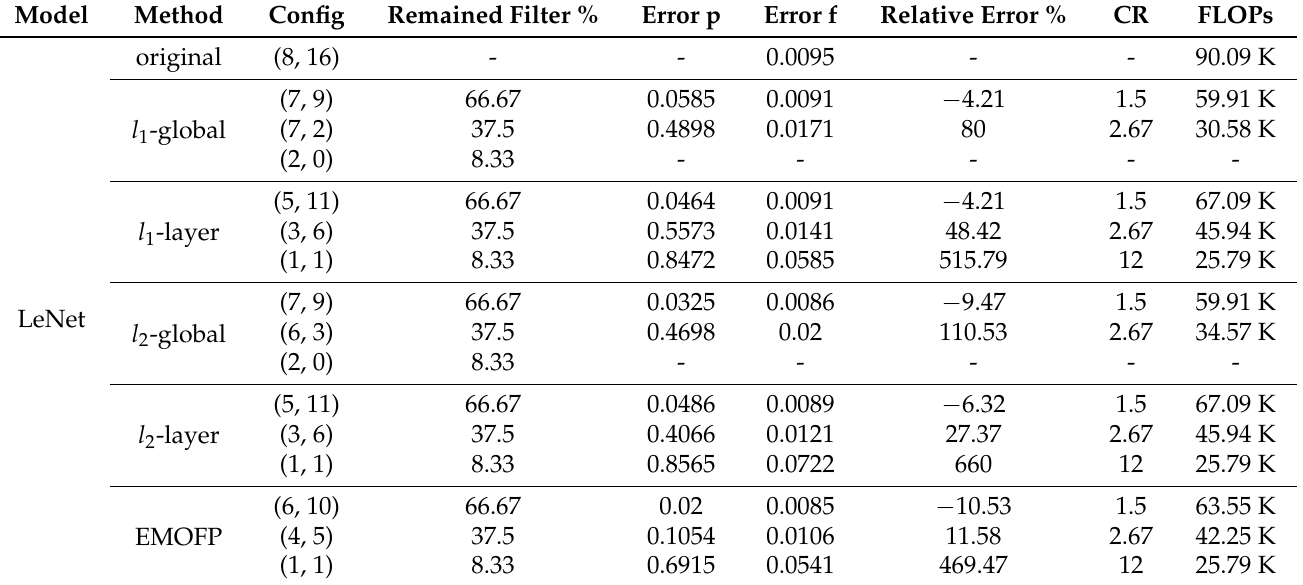
Figure 4. Pareto front of EMFP and scatter plot of fine-tuned solutions on LeNet. Table 7. Pruning results of LeNet on